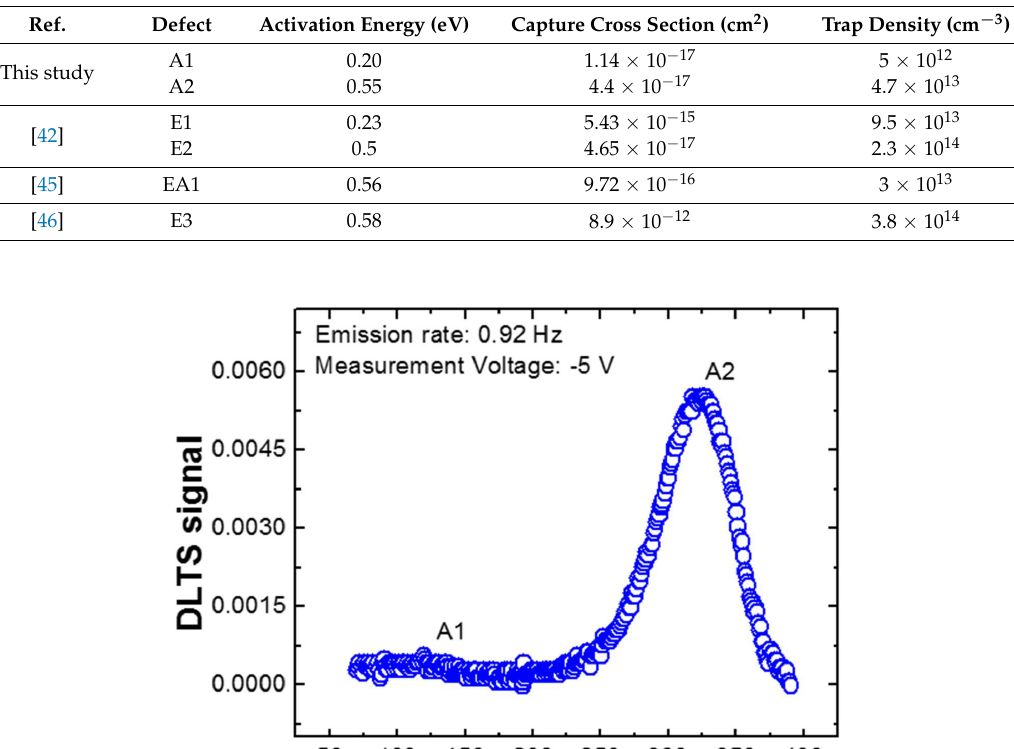
Table 1. Defect parameters for Au/a-plane GaN Schottky diodes.